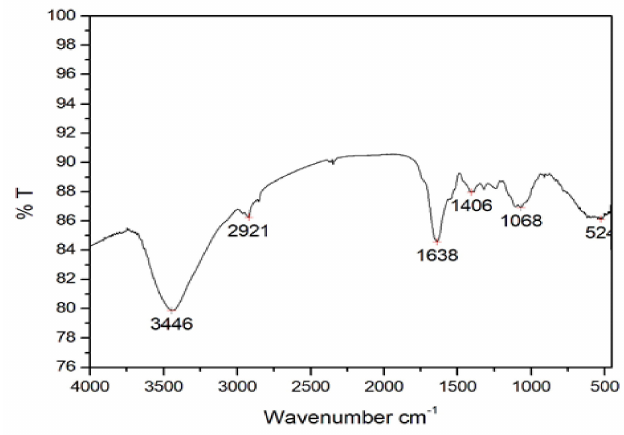
Figure 6. Fourier-Transform Infrared (FTIR) spectrum of the M. oleifera leaves